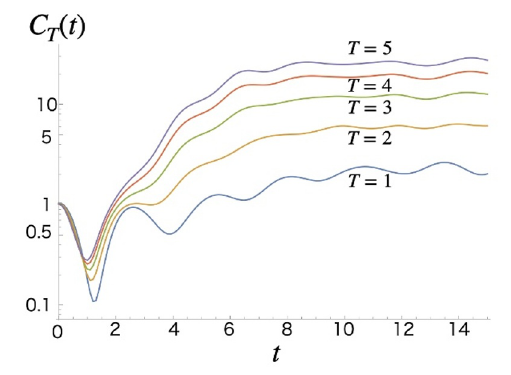
Figure 5 . Log plot of the time evolution of the thermal OTOC for various values of the tempera- ture T .